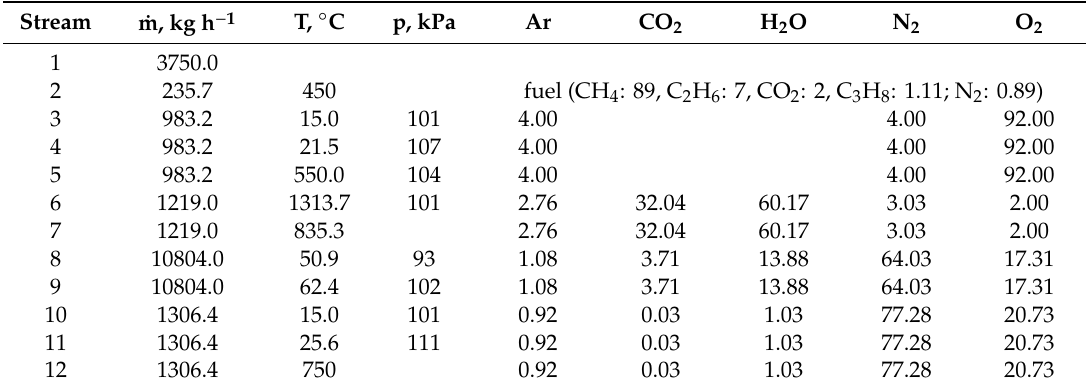
Table A2. Mass flow rates, temperatures, pressures and compositions (mol.%) at the main stations in Figure 12 for a glass melting furnace with production of 90 ton day − 1 .